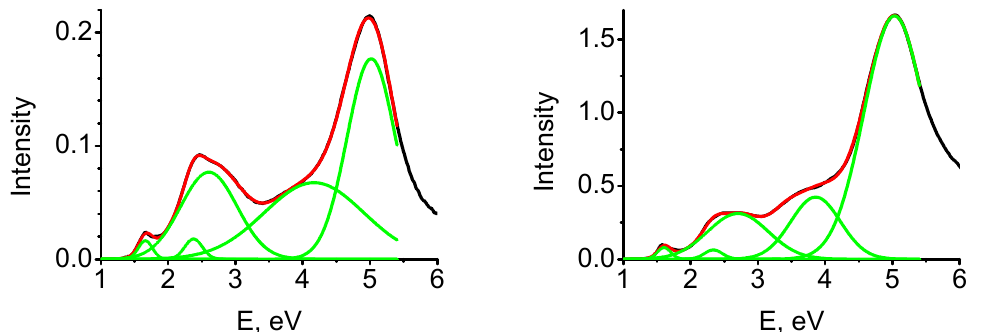
Figure 9. The Kubelka–Munk function (red) and the contributions of different absorption bands (green) for TNT–MgO composites with TNT concentrations of 0.27% ( left ) and 2.5% ( right ).